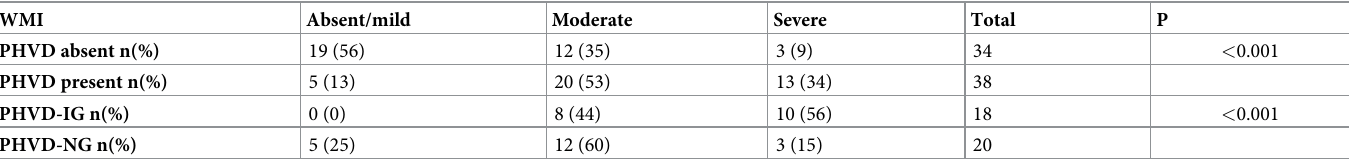
Table 2. White matter abnormalities by study group.